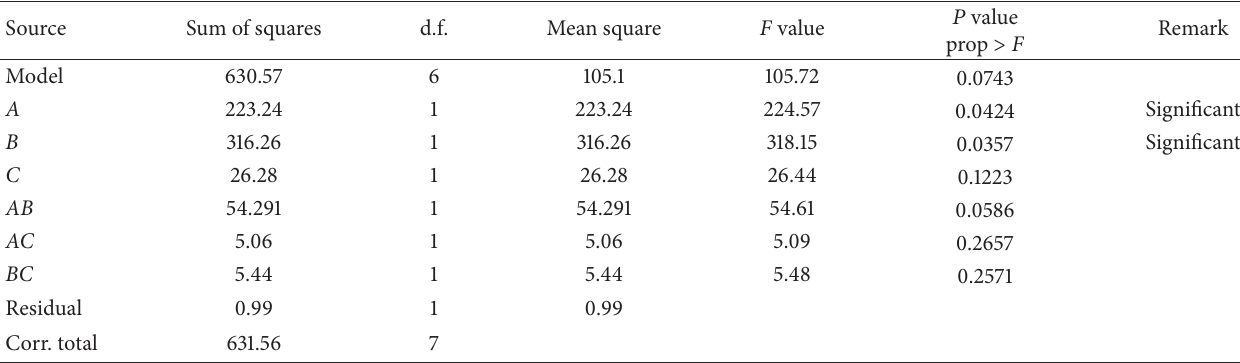
Table 4: ANOVA for 2 3 full factor experimental design.